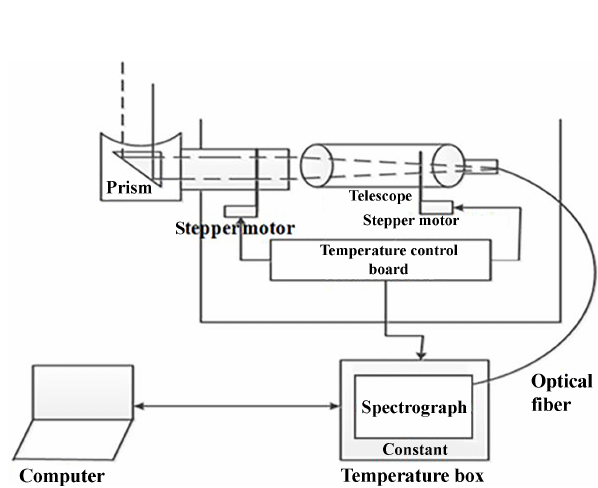
Figure 1. Supersite on the Yanqi Lake campus of UCAS.